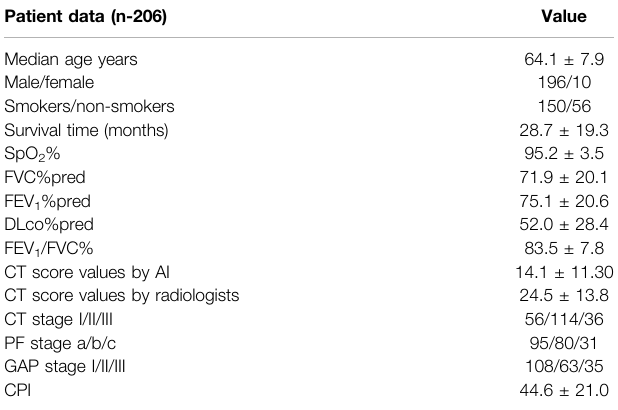
TABLE 2 | Patients ’ general clinical